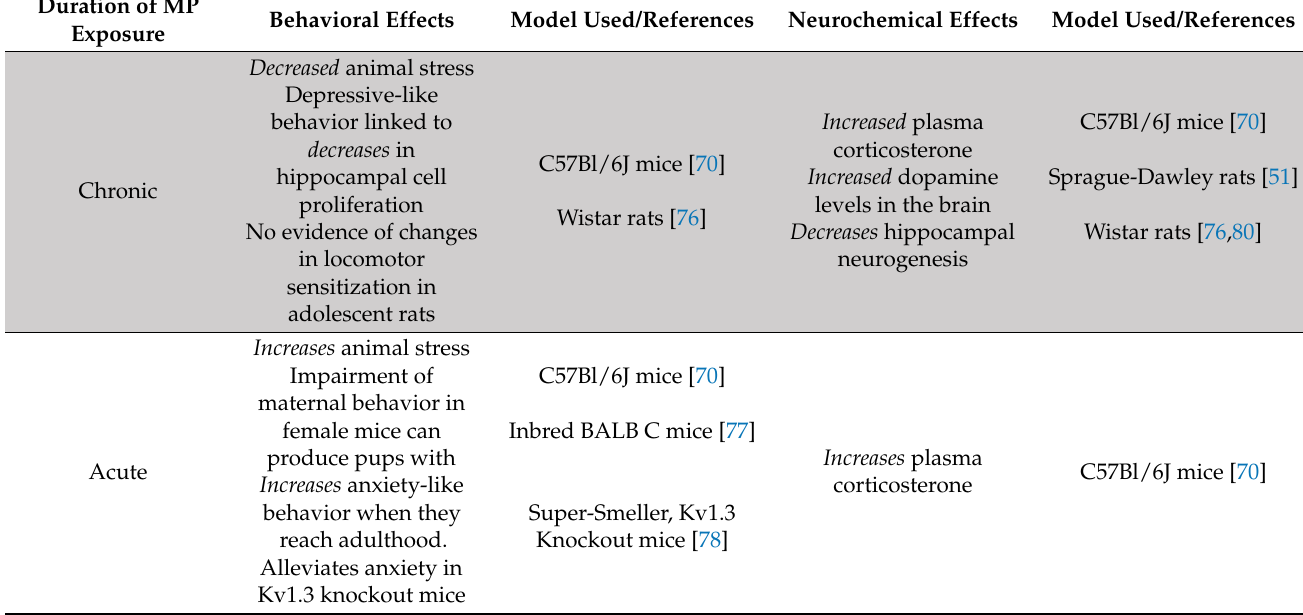
Table 2. Summary of behavioral and neurochemical effects of gavage